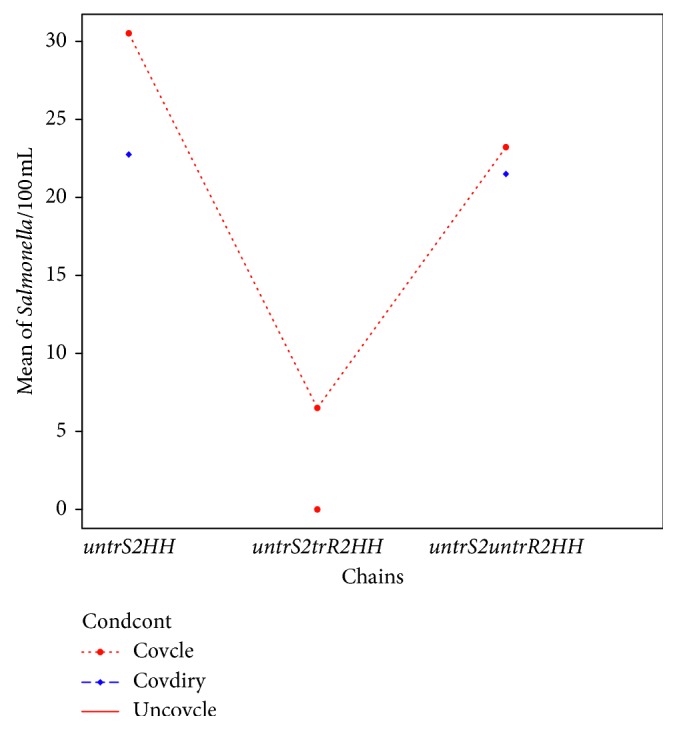
Interaction between container condition, water-handling chains, and Salmonella counts CFU/100 mls (untrS2HH = untreated source to households; untrS2trR2HH = untreated source to treated reservoir to households; untrS2untrR2HH = untreated source to untreated reservoir to households; covcle = covered and clean; covdir = covered and dirty; uncovcle = uncovered but clean).